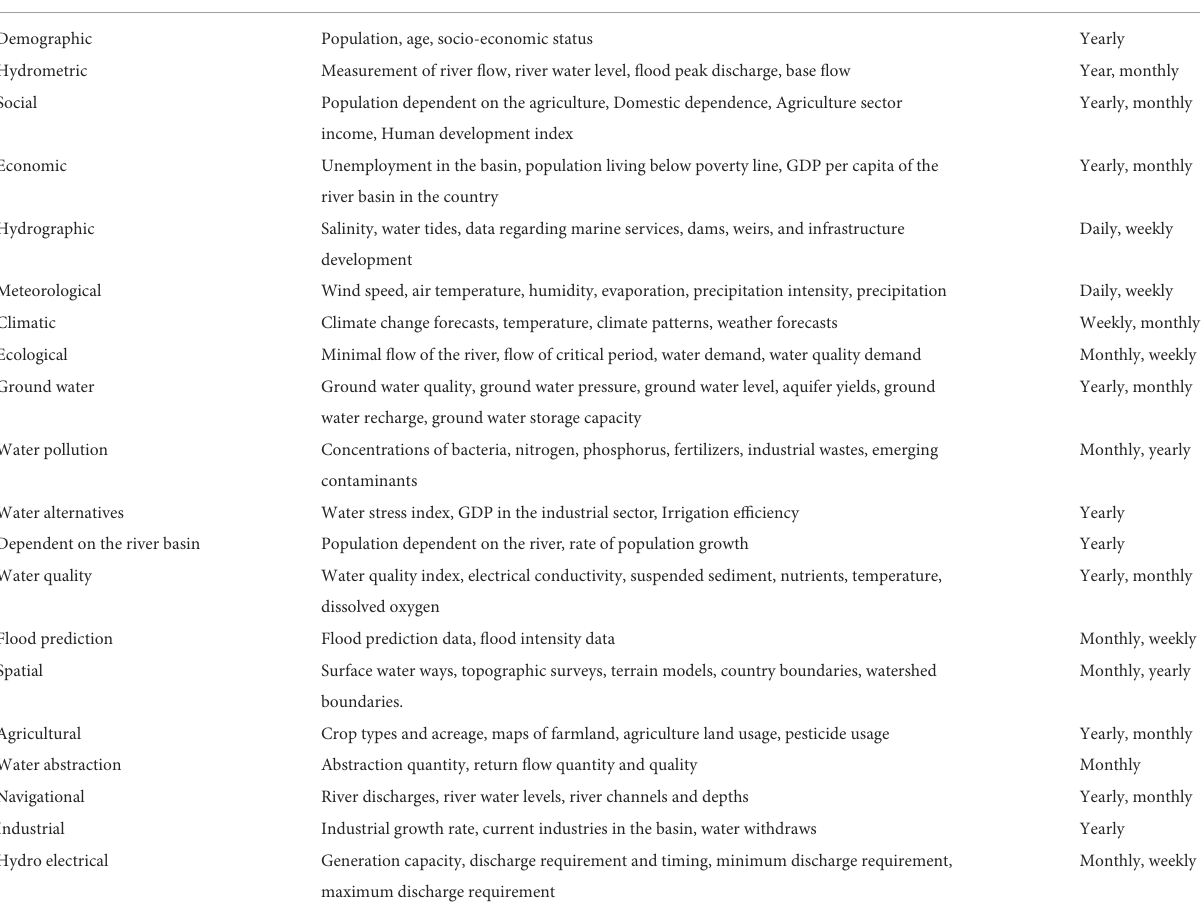
TABLE 1 Types of data scholars argue should be shared among riparian states to enhance cooperation and build